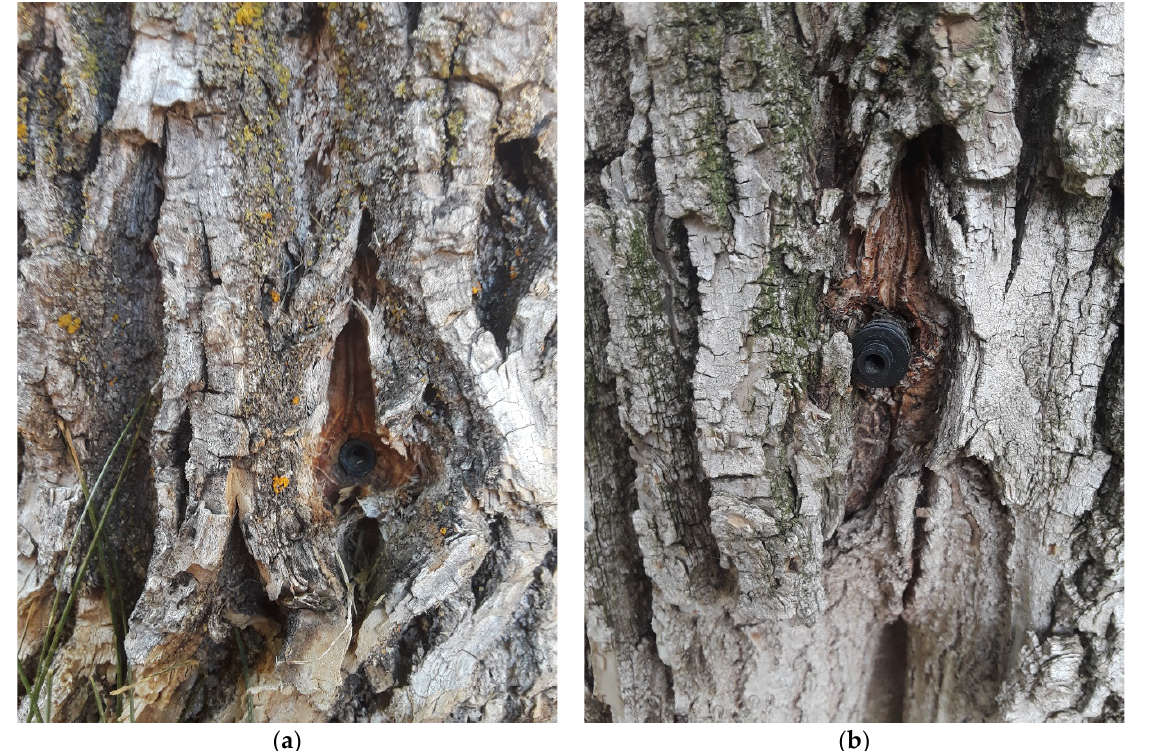
Figure A1. Example street setting of green ash trees from used in this study from a (a) distance and (b) and (b) closeup.